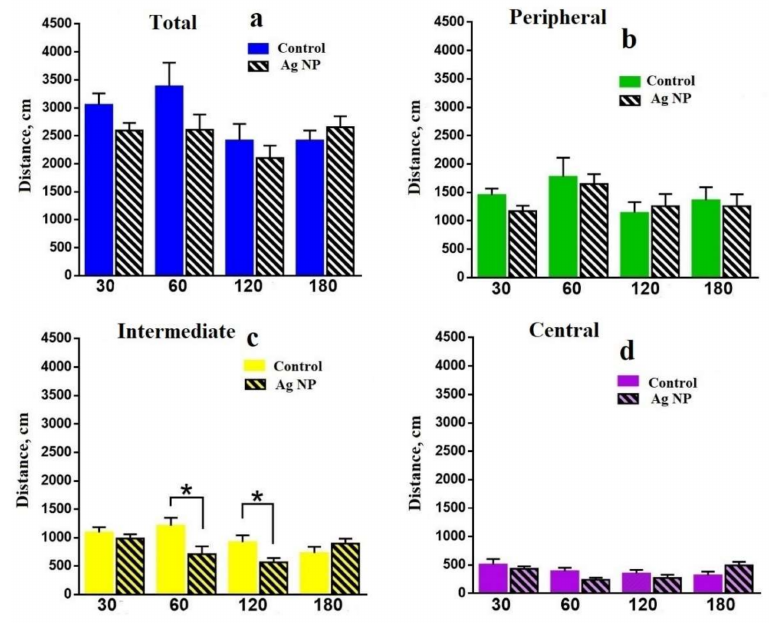
Figure 4. Distance traveled in the areas of the Open Field (OF): total distance ( a ); in the Peripheral area ( b ); in the Intermediate area ( c ); in the Central area ( d